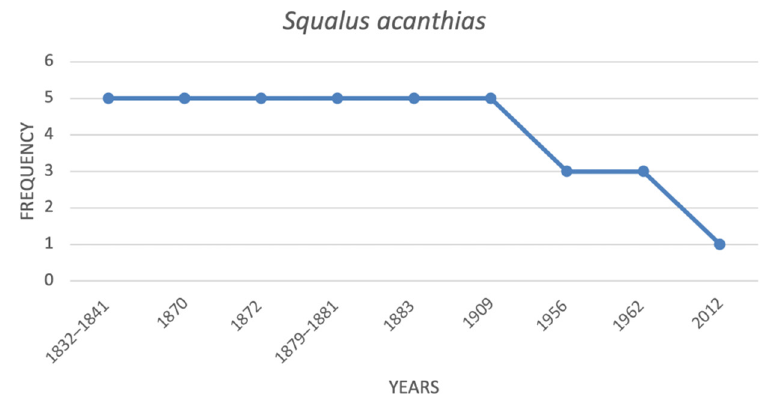
Figure 3. Temporal trend of Squalus acanthias.